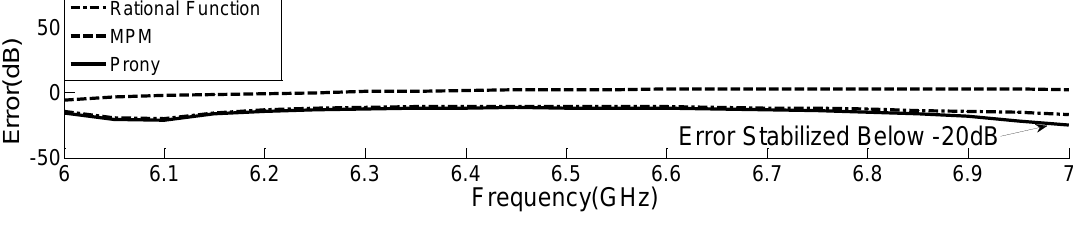
Figure 7. F-117 RCS prediction results at 153 deg. Figure 8. F-117 RCS prediction errors at 153 deg.